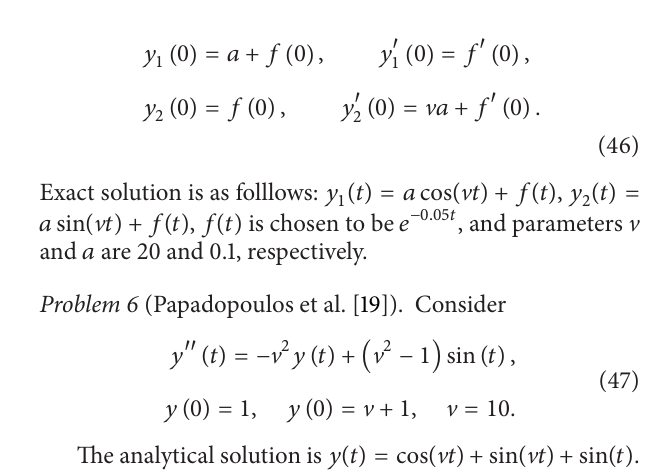
Figure 6: The efficiency curves of the optimized and phase-fitted order five methods and their comparisons for Problem 7 with 𝑡 10 4 and ℎ = 0.125/2 𝑖 , 𝑖 = 1, ...,5 .